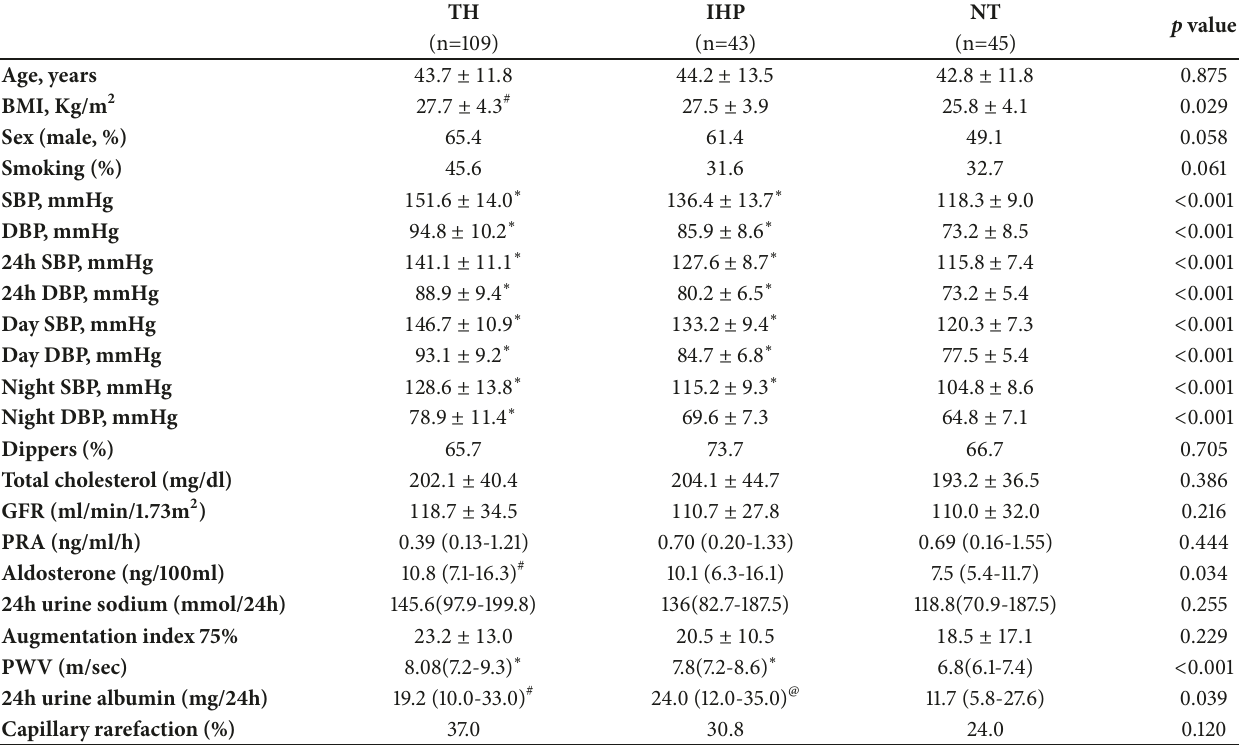
Table 1: Baseline characteristics of the study population.